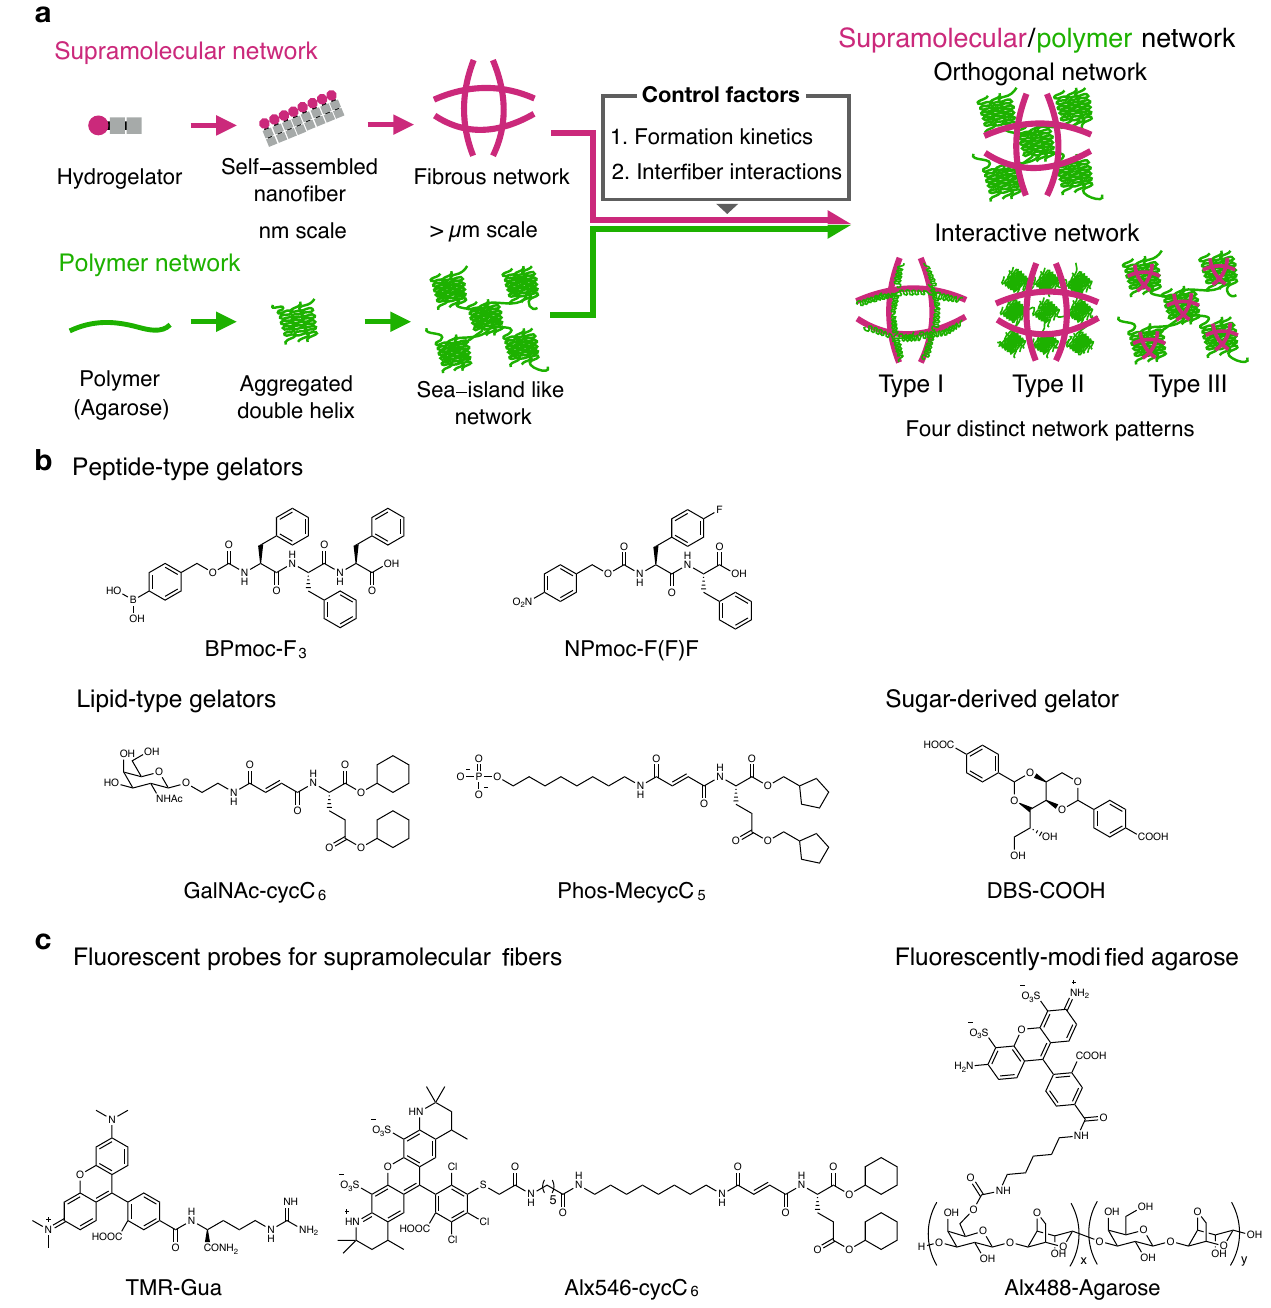
Fig. 1 | Four distinct network patterns of supramolecular/polymer composite hydrogels.a Schematic illustration of four distinctnetwork patterns in composite hydrogels. b Chemical structures of representative peptide-type, lipid-type, and